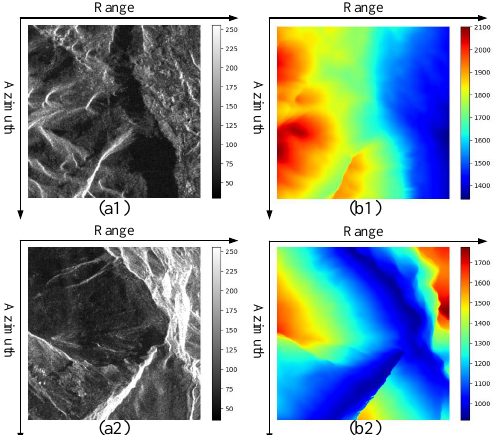
Figure 1. Two examples of acquired SAR ( a1 , a2 ) and its corresponding geocoded ground truth DEM ( b1 , b2 ). The color bar represents the height information, and the unit is